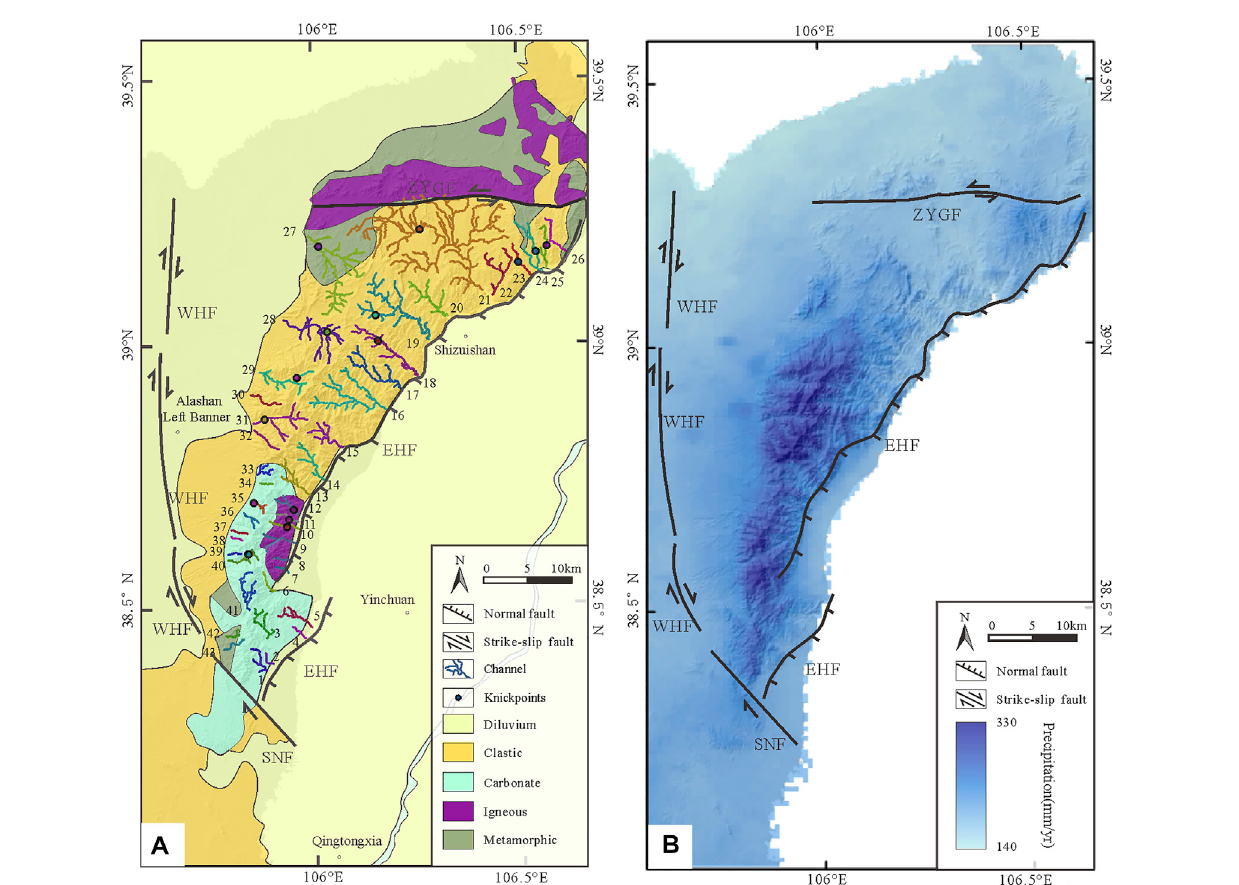
Frontiers in Earth Science |